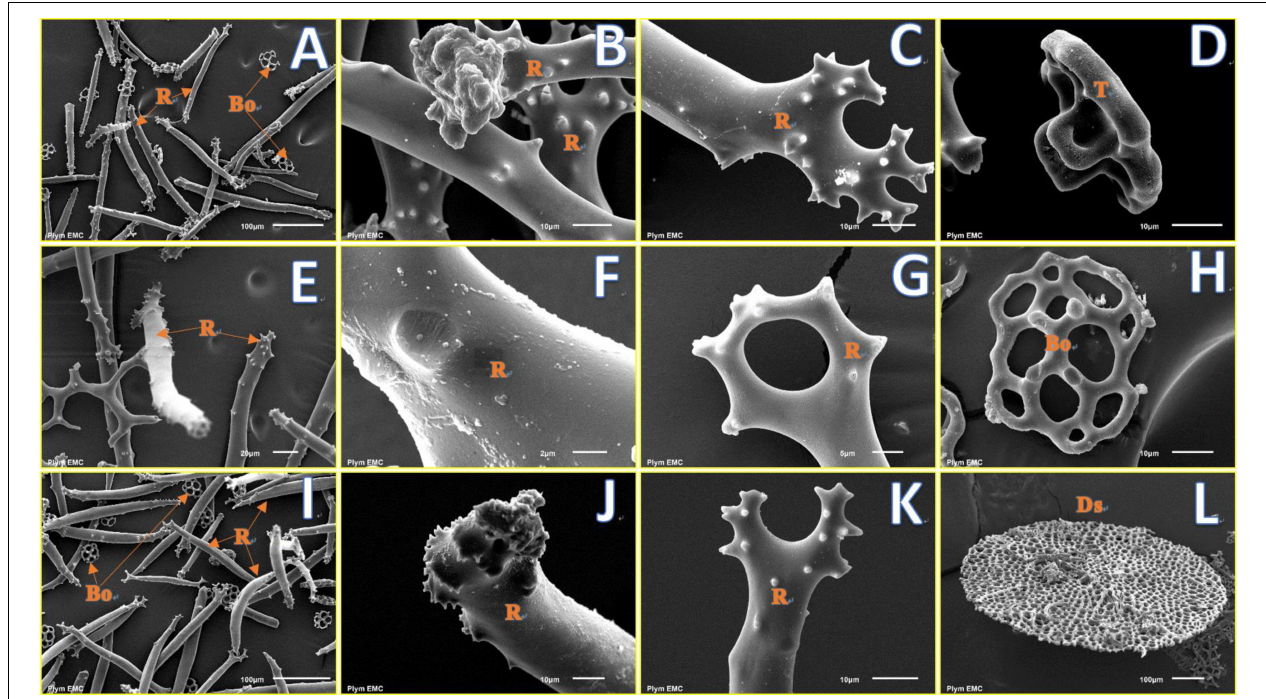
FIGURE 4 | Fine structure of skeletal ossicles in the sea cucumber H. forskali from pH 7.97 (control, A–D ), pH 7.88 (E–H) , and pH 7.79 (I–L) treatments after 22 weeks. (A,E,I) show types of ossicles from buccal tentacles; (B,C,G,J,K) show fine structure of the ends of rods; (D) shows table; (H) shows button; (F) shows fine structure of the middle part of a rod; (L) shows a large disk from ventral body wall. R, rod; Bo, button; T, tables; Ds, disk.